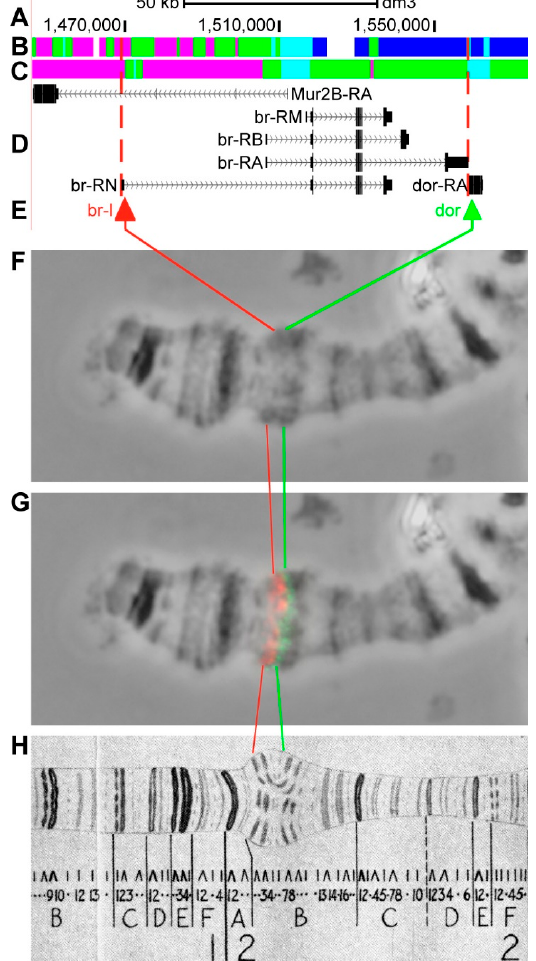
Figure 8. Localization of the br gene in the 2B region (the gene is bound by red dotted lines). (A) the scale (kb) and genomic coordinates (bp); (B) the four chromatin-state model [39]; (C) the chromatin condensation level model [32]; (D) genes location (arrow lines show the gene orientation and black bars indicate the location of gene exons); (E) probes location; (F) phase-contrast micrograph of the region; (G) combined FISH signals; and, (H) C. Bridges’ chromosome map [25].